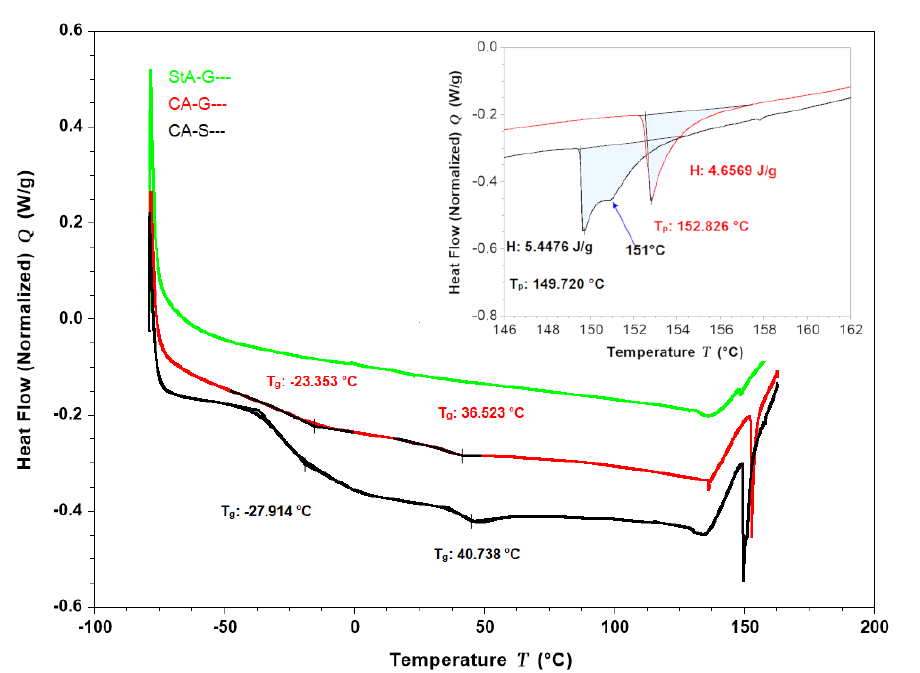
Figure 3. DSC thermograms of casting films: StA-G ( ), CA-G ( ), and CA-S ( ). Zooming in on a portion of the graph showing the melting point of the CA-G and CA-S films.